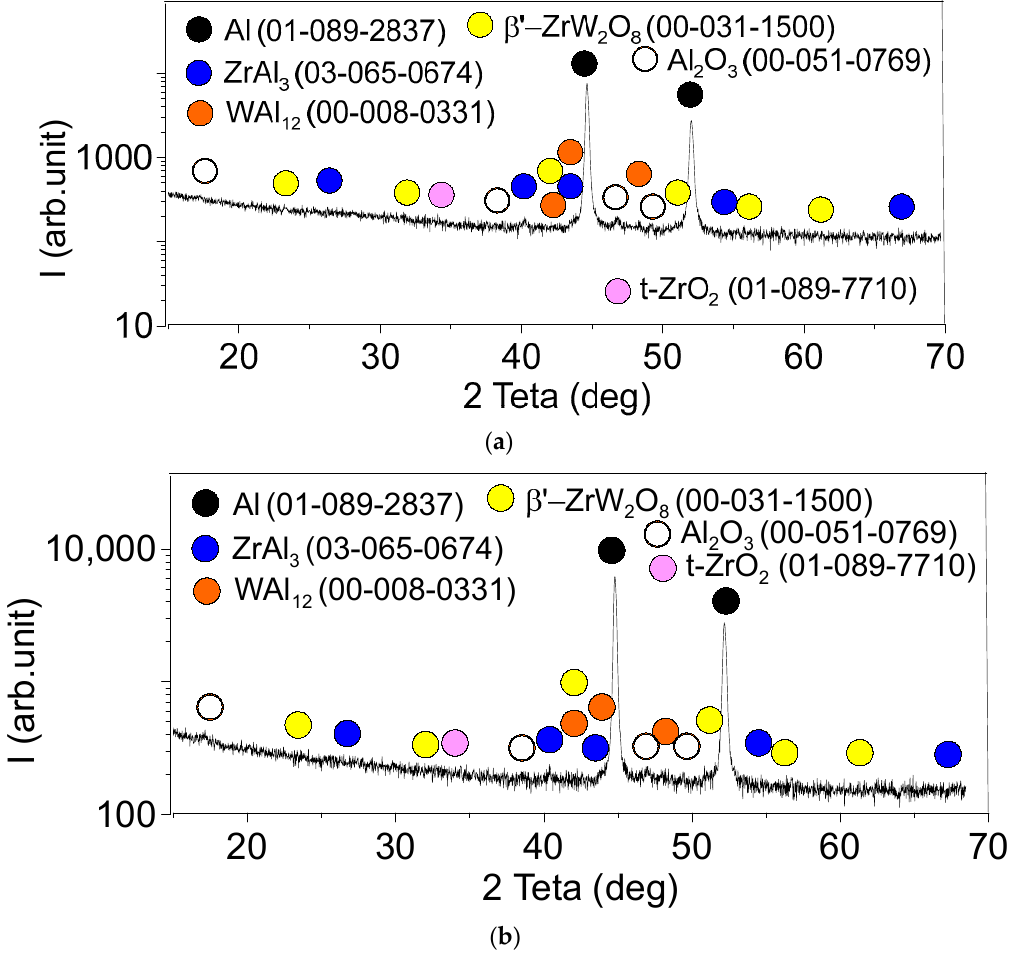
Figure 15. The XRD patterns of FSP-ed RPPs/AA 5056 composite after 4 ( a ) and 8 ( b ) passes.